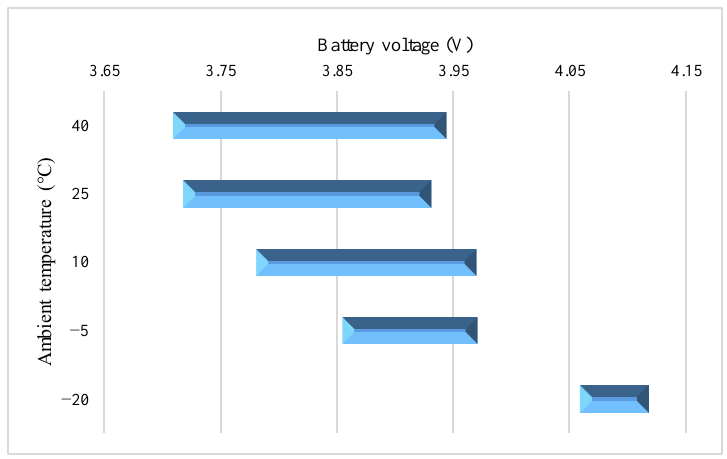
Figure 14. The voltage fluctuation intervals during the VPP with 0.75C charging.